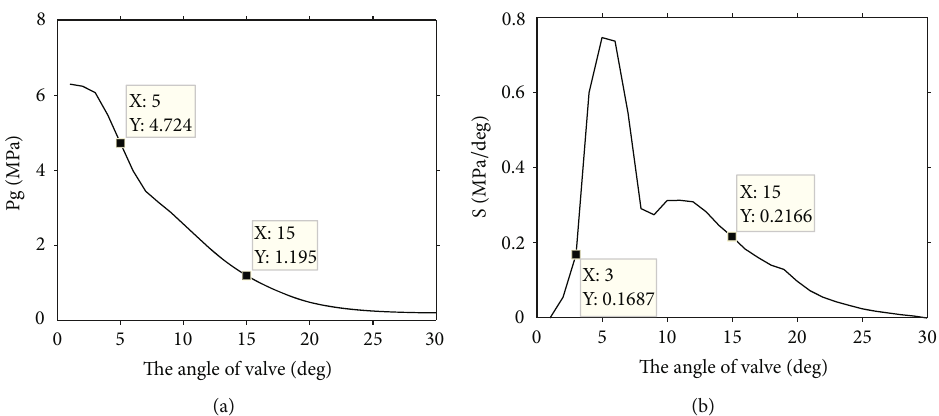
Figure 3: Relationship among pressure, sensitivity coe ffi cient, and valve angle. (a) The valve angle and pressure. (b) The valve angle and sensitivity coe ffi cient.